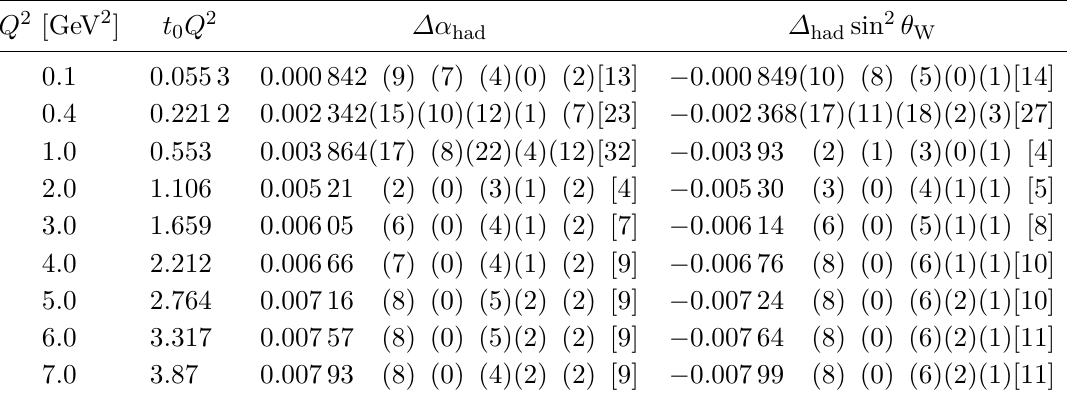
Table 6 . Total HVP contribution to the running of α and sin 2 θ W . After the statistical error and the fit, scale-setting and charm-sea-quark systematic errors propagated from the ¯ Π results in table 5, the fifth uncertainty is the systematic error from missing isospin-breaking effects (see section 4.2.3). The final uncertainty quoted is the combination of the previous